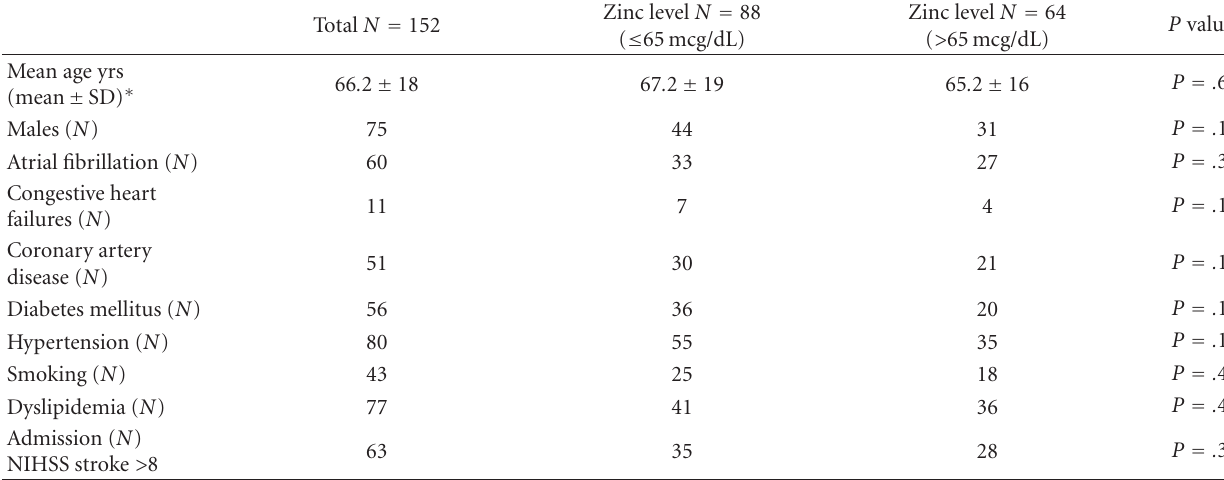
Table 2: Characteristics of patients with Ischemic Stroke and association with Low Zinc levels ( ≤